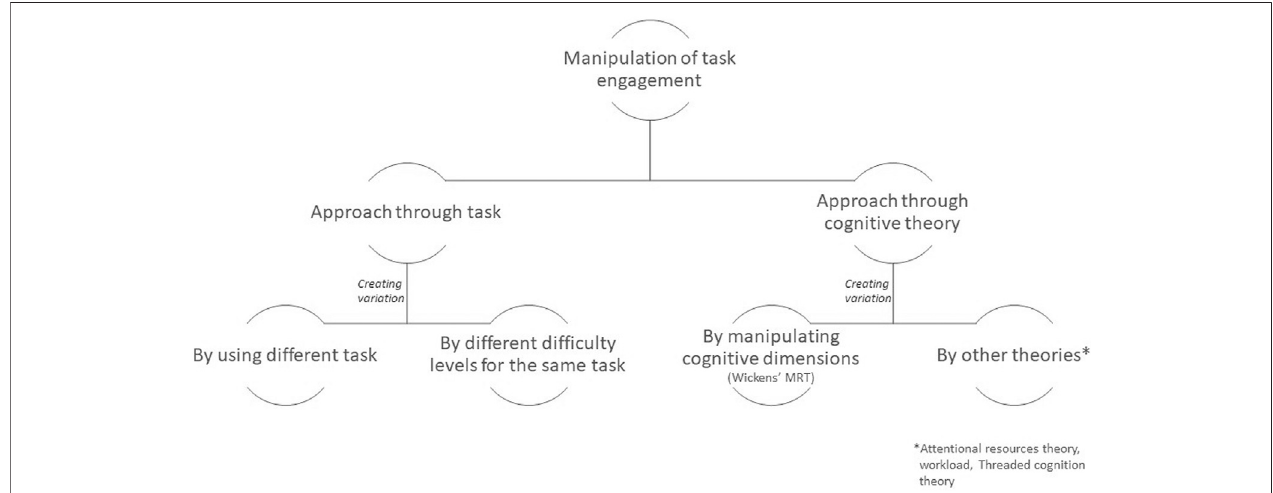
FIGURE 1 | Illustration of task engagement manipulation in the selected